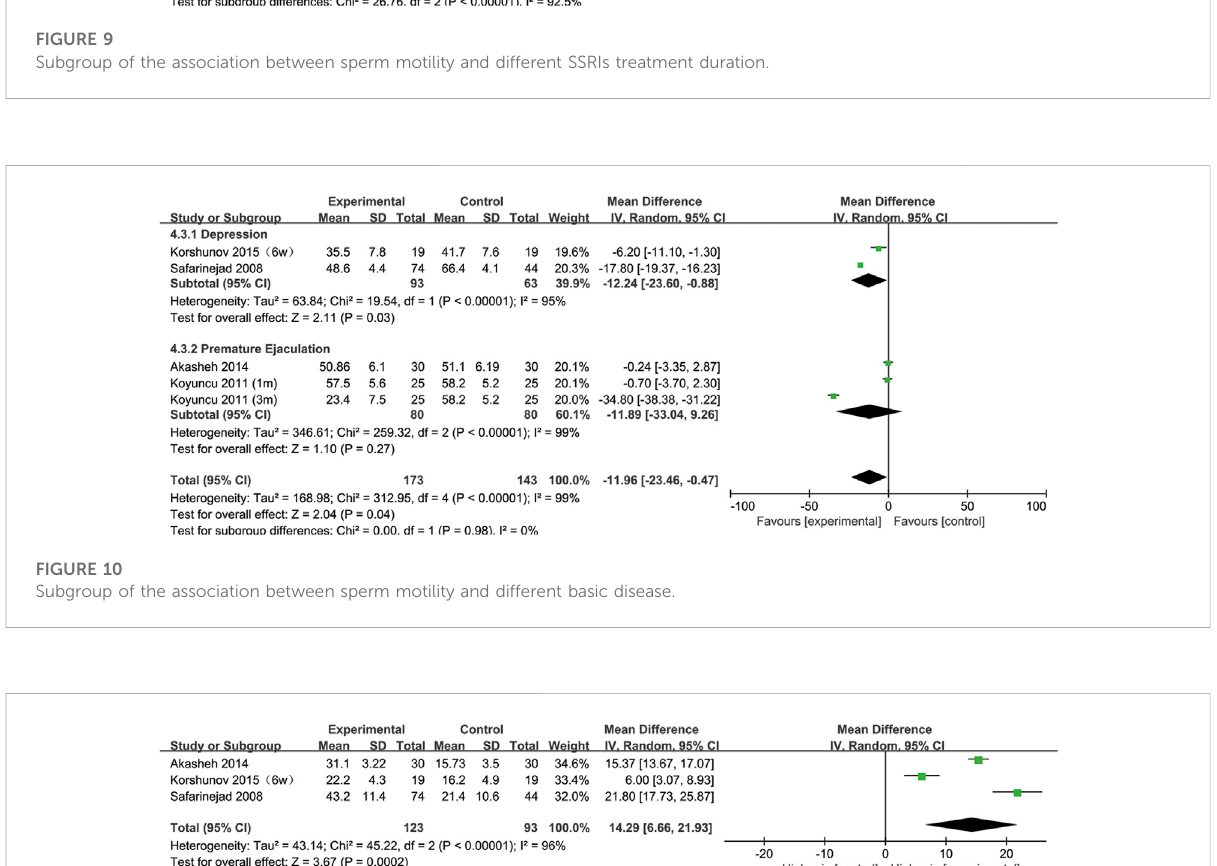
Three studies provided sperm DFI data (Safarinejad, 2008; Akasheh et al., 2014; Korshunov et al., 2015). As shown in Figure 11, the DFI in the experimental group was signi fi cantly higher than that in the control group (95% CI [6.66, 21.93], p =